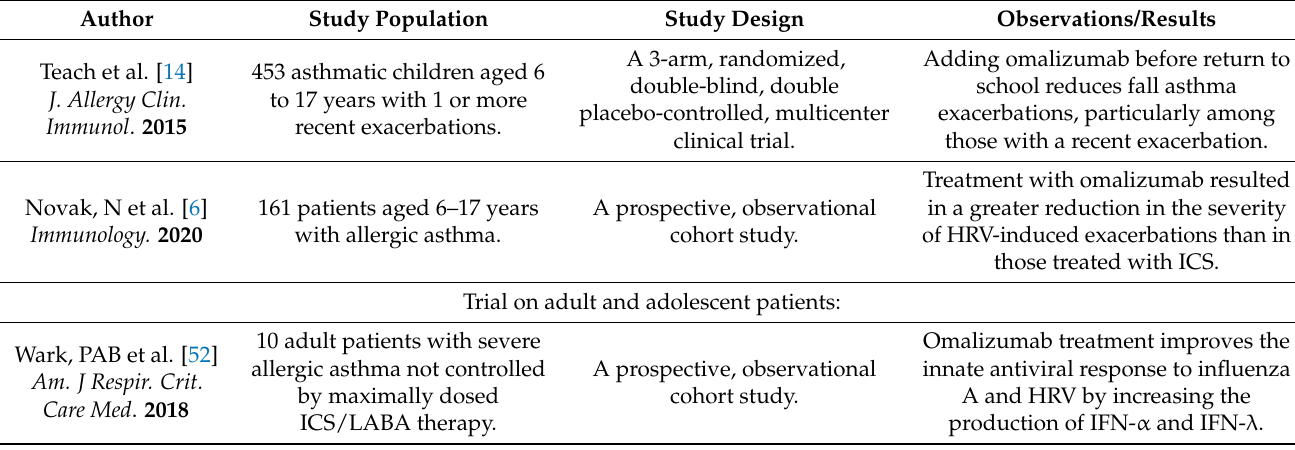
Table 2. Studies conducted on patients with moderate-to-severe allergic